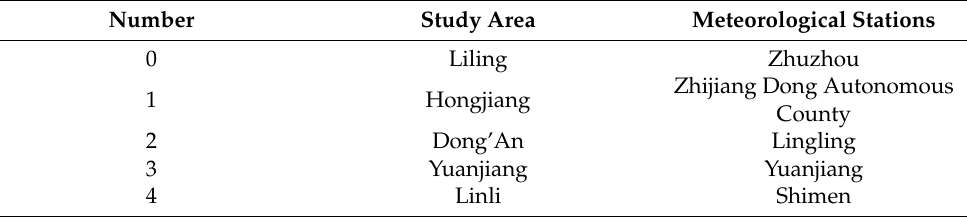
Table 3. The study areas and the corresponding meteorological